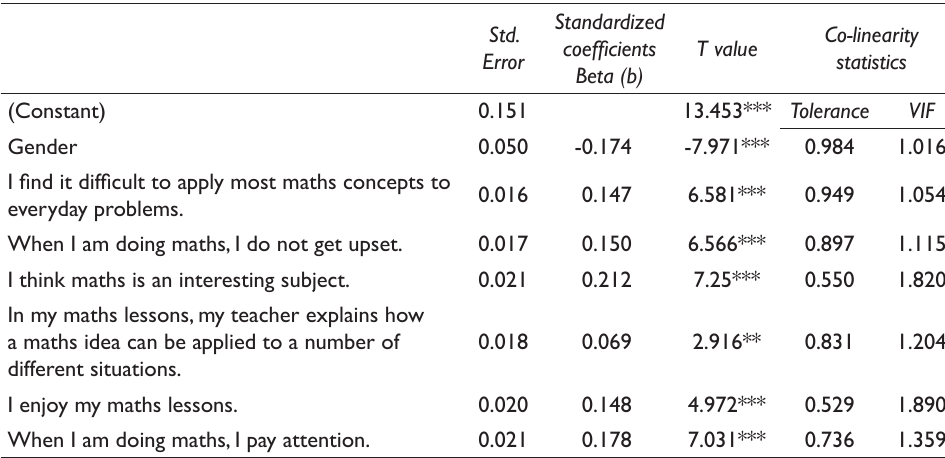
Table 6: OLS regression estimates of factors that influence London secondary school students’ self- concept in